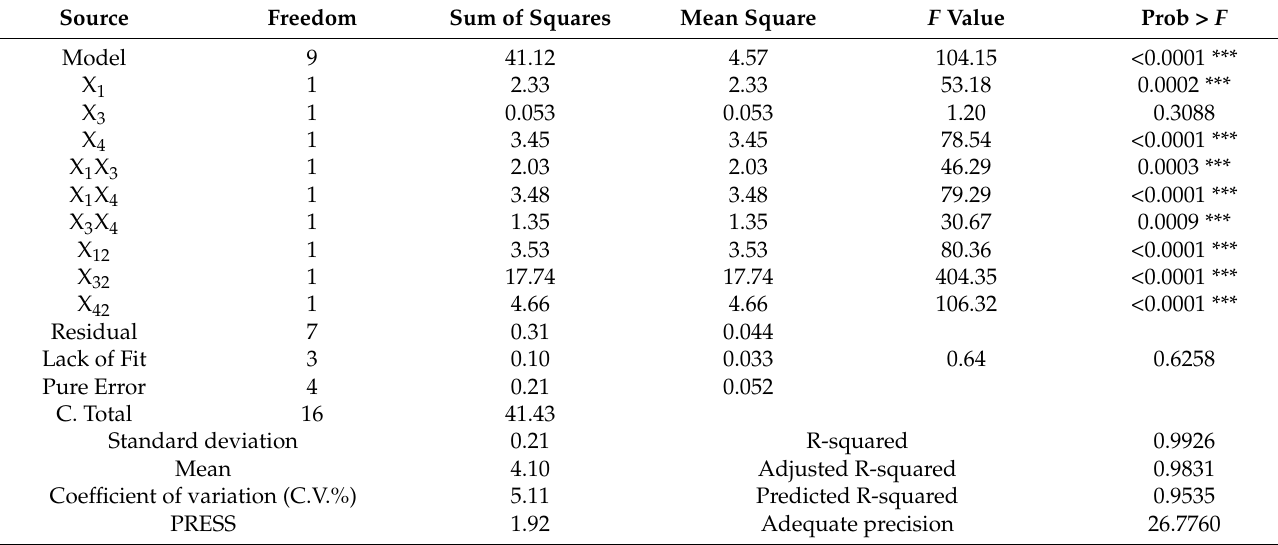
Table 7. Analysis of variance of BBD.